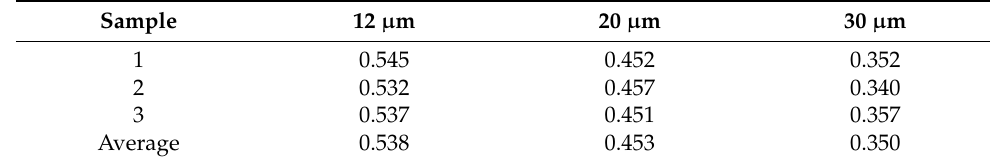
Table 2. Roughness of three silicon-based microchannels.